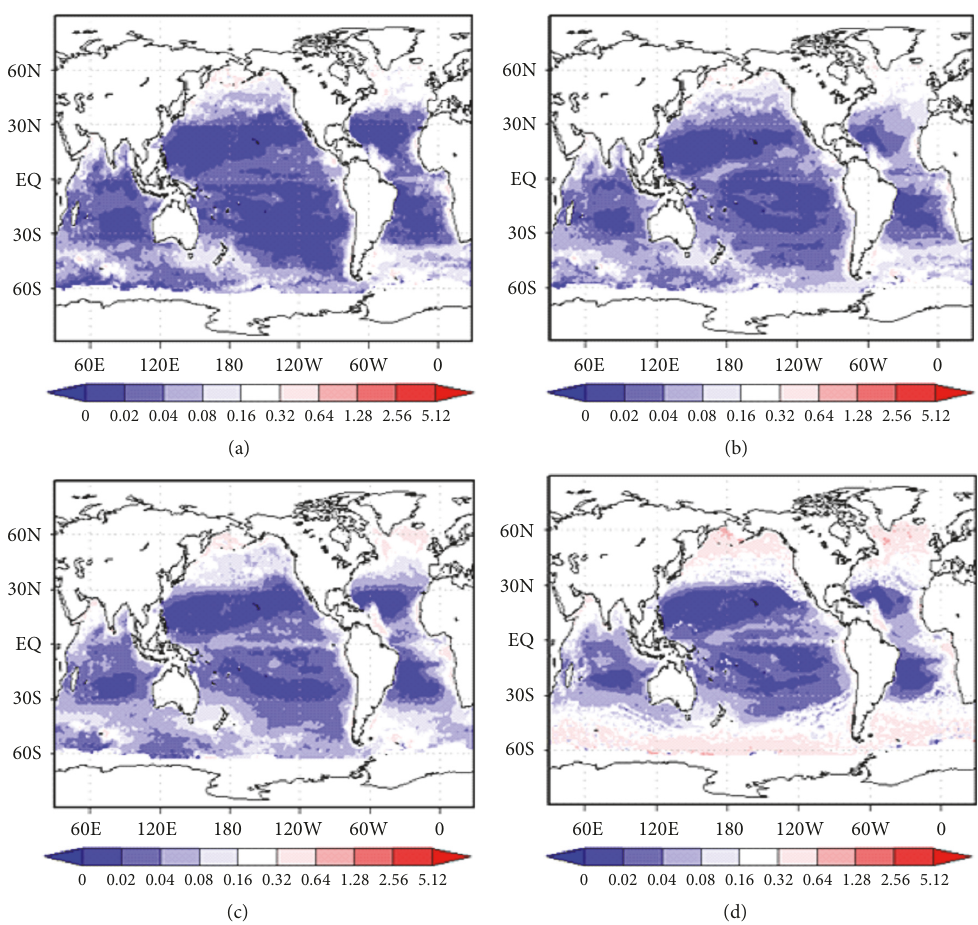
Figure 14: Root-mean-square errors (RMSE in mg/m 3 ) of monthly mean chl-a fields: (a) LN-NN versus VIIRS (2012–2014), (b) NN versus VIIRS (2012–2014), (c) LN-NN versus SeaWiFS (2005–2010), and (d) NN versus SeaWiFS